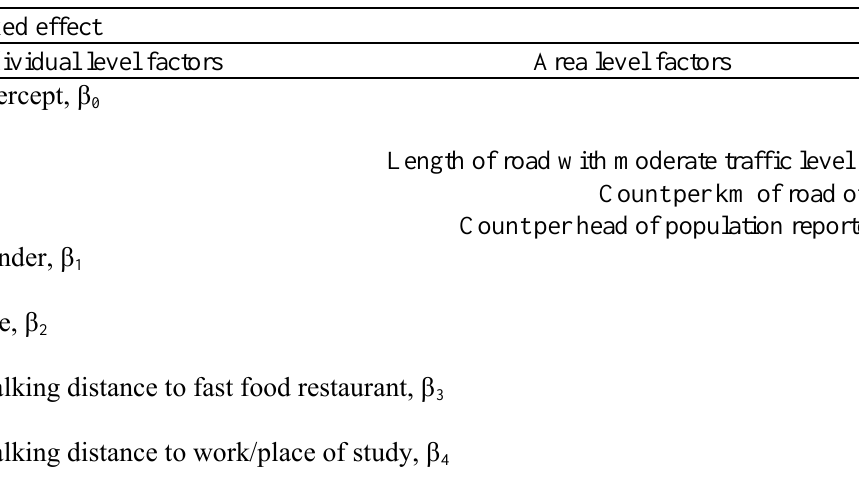
Table 6. Summary of fixed effects for the multi-level model for activity outside